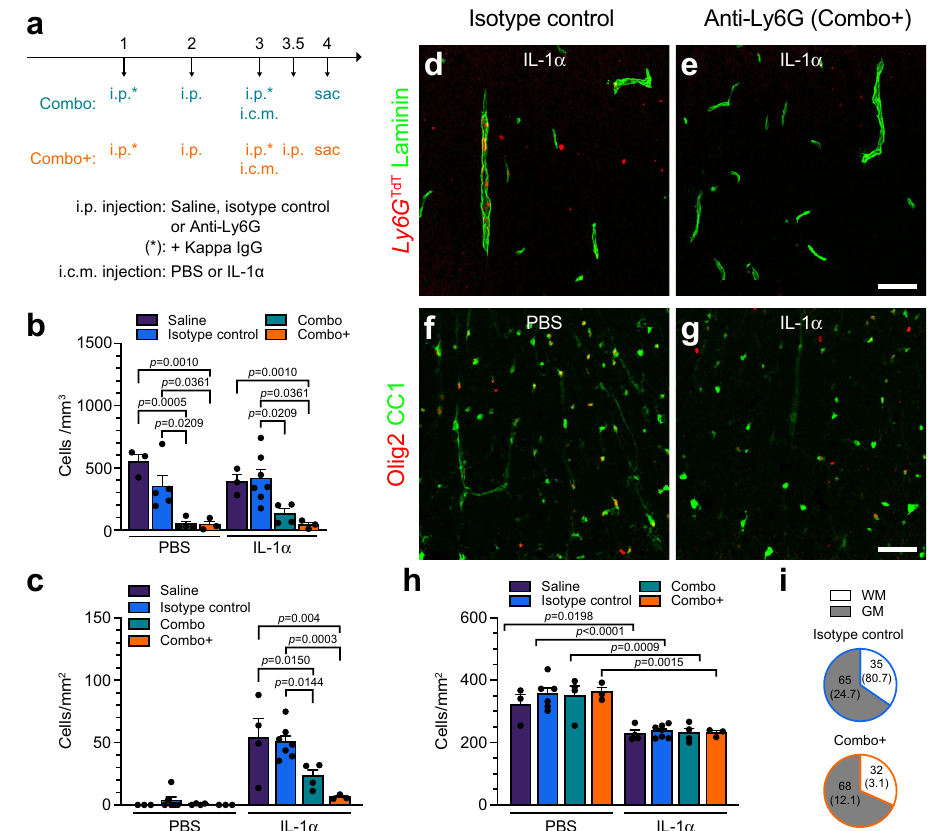
Fig.9|DepletionofneutrophilsdoesnotalterIL-1 α -mediatedoligodendrocyte loss. a Diagram showing the experimental design and timeline of the depletion study. Abbreviations: Combo, combination strategy; Combo + , adapted combina- tion strategy; i.c.m., intra-cisterna magna; i.p., intraperitoneal; sac, sacri fi ce. b Quanti fi cation by fl ow cytometry of the number of Ly6G TdT+ neutrophils in the bloodofPBS-andIL-1 α -injected Ly6g Cre-TdT :: R26-TdT micepretreatedwitheitherthe Combo + strategy, Combo strategy, isotype control antibodies or saline. Mice were killed at 24h post-i.c.m. injection ( n =3 Saline+PBS, n =5 Isotype control+PBS, n =4 Combo+PBS, n =3 Combo + + PBS, n =3 Saline + IL-1 α , n =7 Isotype control + IL-1 α , n =4 Combo + IL-1 α , n =3 Combo + + IL-1 α ). c Quanti fi cation of Ly6G TdT+ neutrophilsthatin fi ltratedthespinalcordat24hpost-i.c.m.injection( n =3Saline+ PBS, n =6 Isotype control + PBS, n =4 Combo + PBS, n =3 Combo + + PBS, n =4 Saline + IL-1 α , n =7 Isotype control + IL-1 α , n =4 Combo + IL-1 α , n =3 Combo + + IL- 1 α ). d , e Confocal images showing Ly6G TdT+ cells (red) and laminin (green) in the